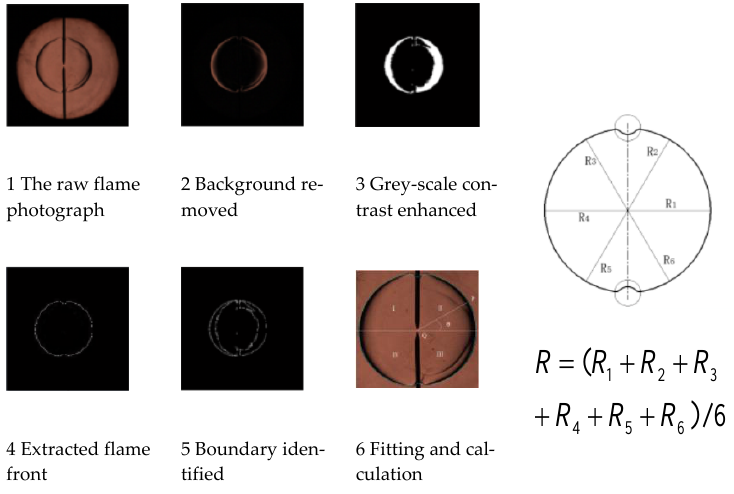
Figure 2. Diagram of flame radius extracting data calculating.